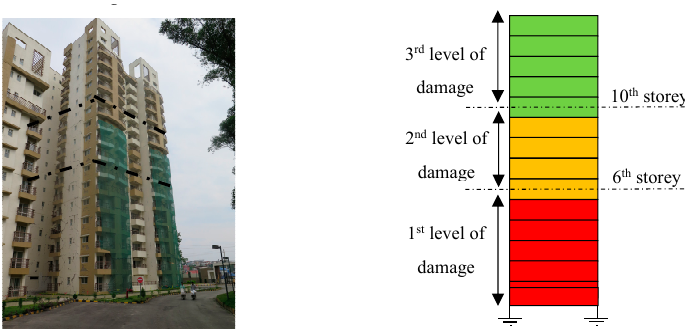
Figure 12. Schematic layout of the infill masonry wall level of damages assumed.